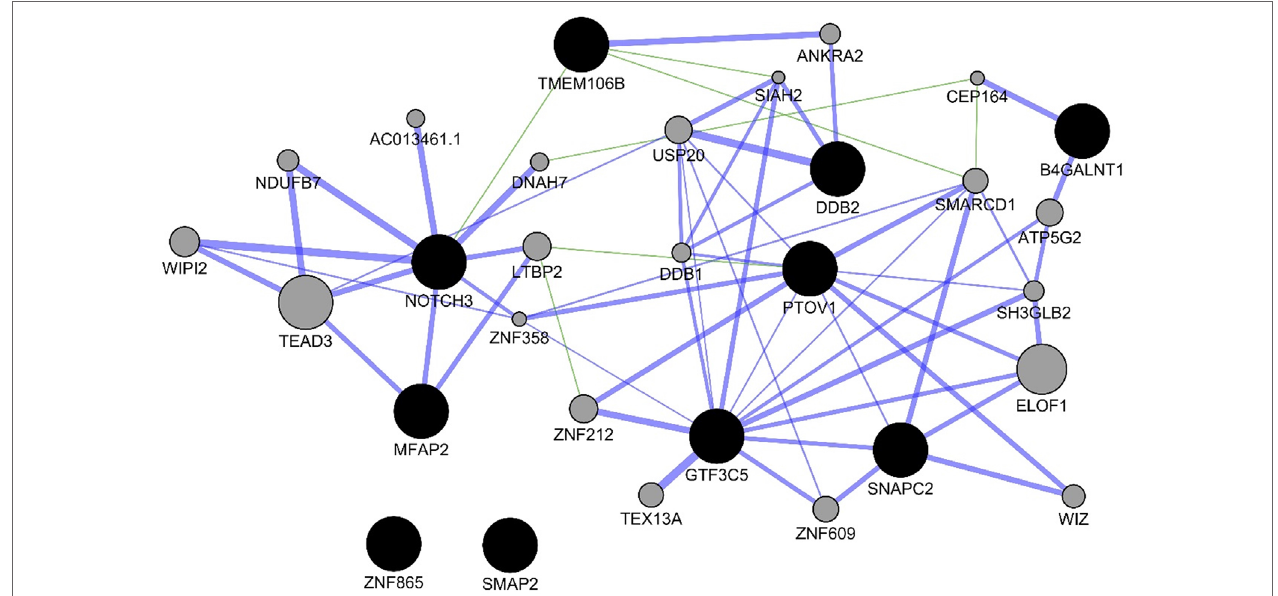
FIGURE 1 | Gene interaction network among the genes from the decision tree models using the protein-coding genes of transcriptomics data. Black circles denote the candidate biomarkers genes, and gray circles denote the GeneMANIA-predicted genes. Blue and green edges represent co-expression (network weight 99.70) and genetic interactions (network weight 0.33), respectively.